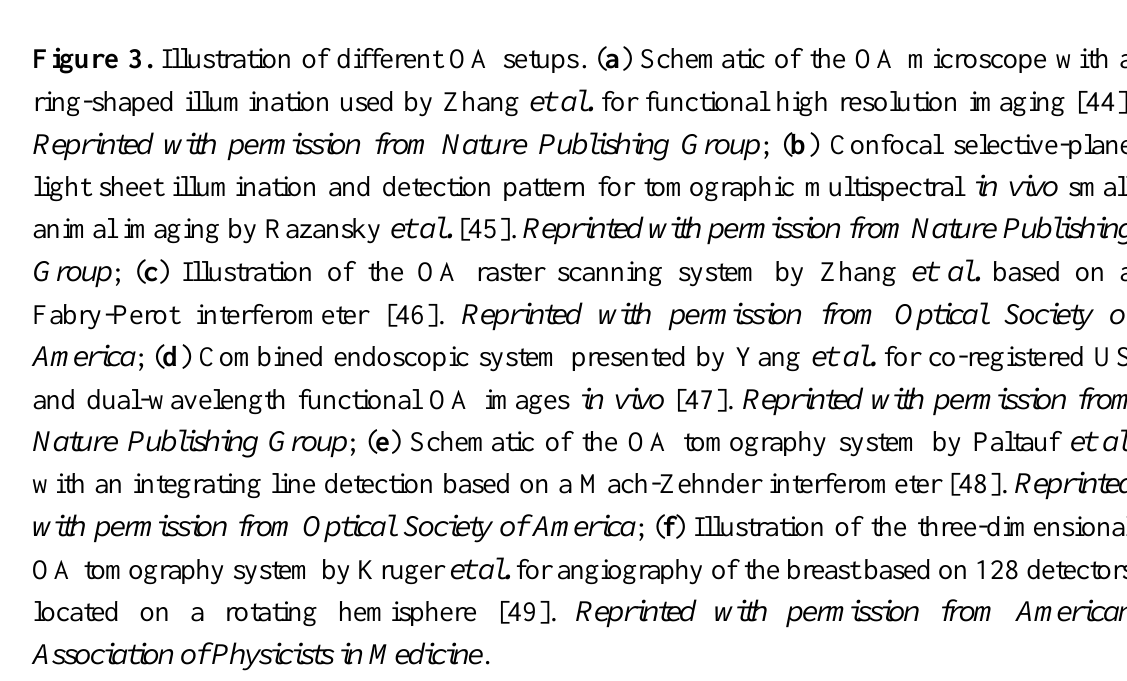
Figure 3. Illustration of different OA setups. ( a ) Schematic of the OA microscope with a ring-shaped illumination used by Zhang et al. for functional high resolution imaging